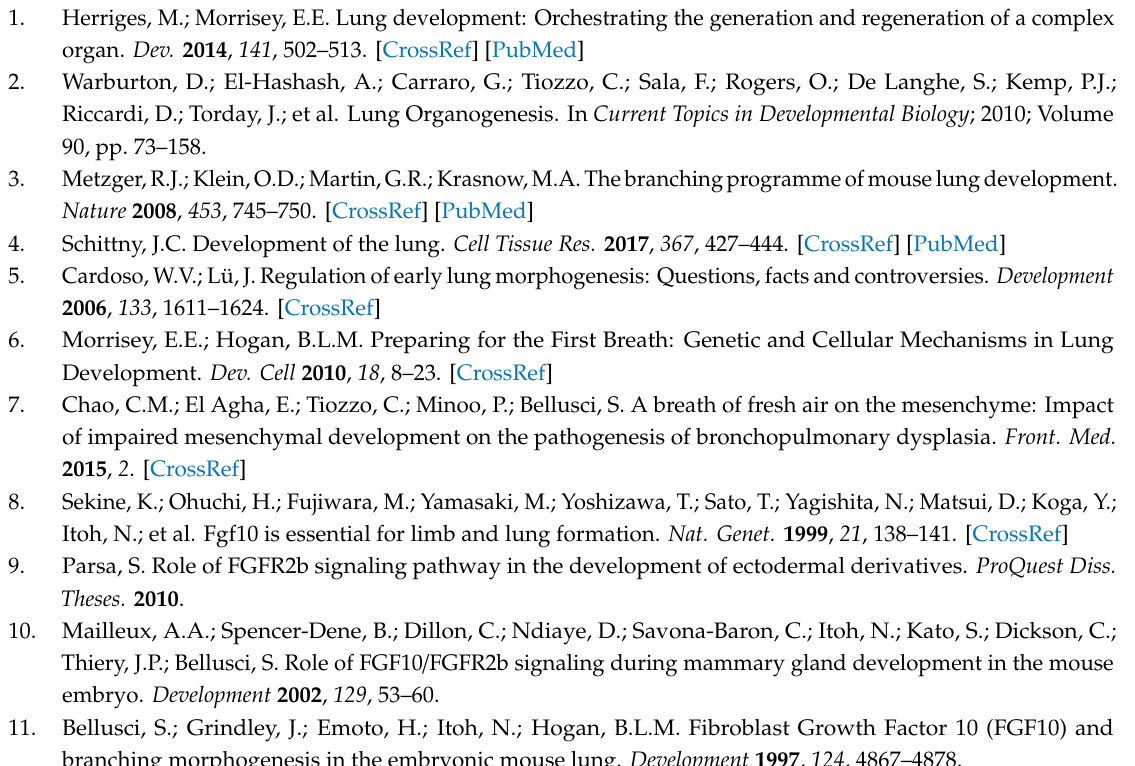
Figure S1: Enlarged heatmap from Figure 1D showing the top 100 regulated genes (according to p-value) from E14.5 + 9 h gene array. Figure S2: Experimental lungs (E14.5 + 9 h.) display impaired AT2, but not AT1, di ff erentiation. Figure S3: Expression patterns of genes directly regulated after 9 h by Fgfr2b signaling in E14.5 lungs. Table S1: Primary and secondary antibodies. Table S2: qPCR